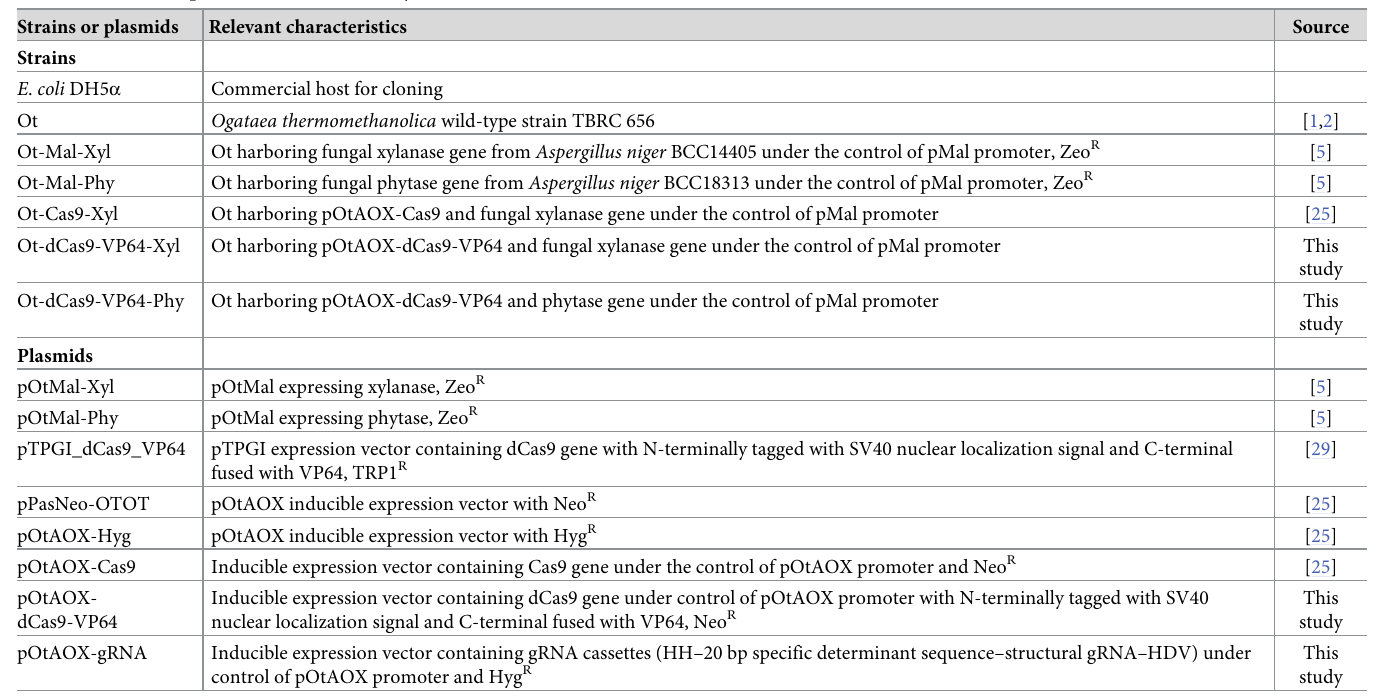
Table 1. Strains and plasmids used in this